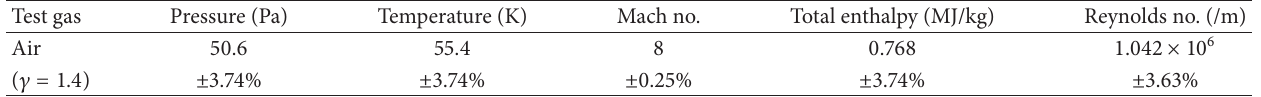
Table 1: Freestream conditions for tests in